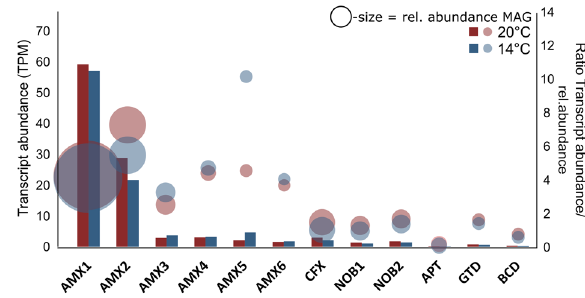
Fig. 6 Relative abundance and transcription of MAGs. Barcharts representing the relative transcript abundance (in TPM) of MAGs recovered from the bioreactor. Bubbles represent the ratio between transcript abundance and corresponding relative abundance for each MAG. The second y -axis denotes the ratio levels. The size of bubbles correspond to the relative abundance of the MAGs. Supplementary Table 2 gives more details on